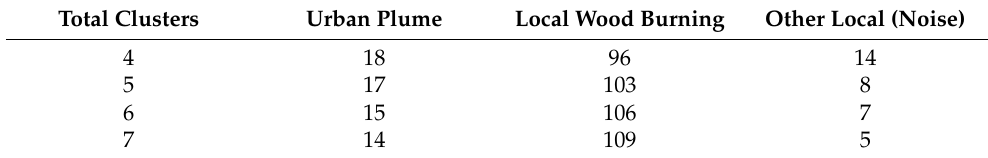
Table 5. Mean source contributions to BC wb (ng/m 3 ) for a different choice of total clusters sought. Total Clusters Urban Plume Local Wood Burning